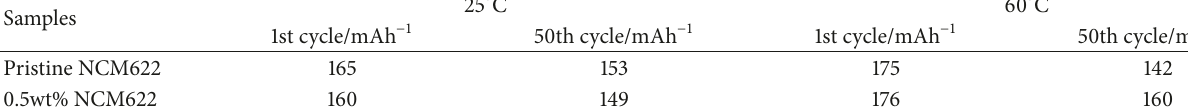
Table 3: Electrochemical properties of Mn 3 (PO 4 ) 2 coated and uncoated NCM622 cathode materials at different temperatures [41]. Samples